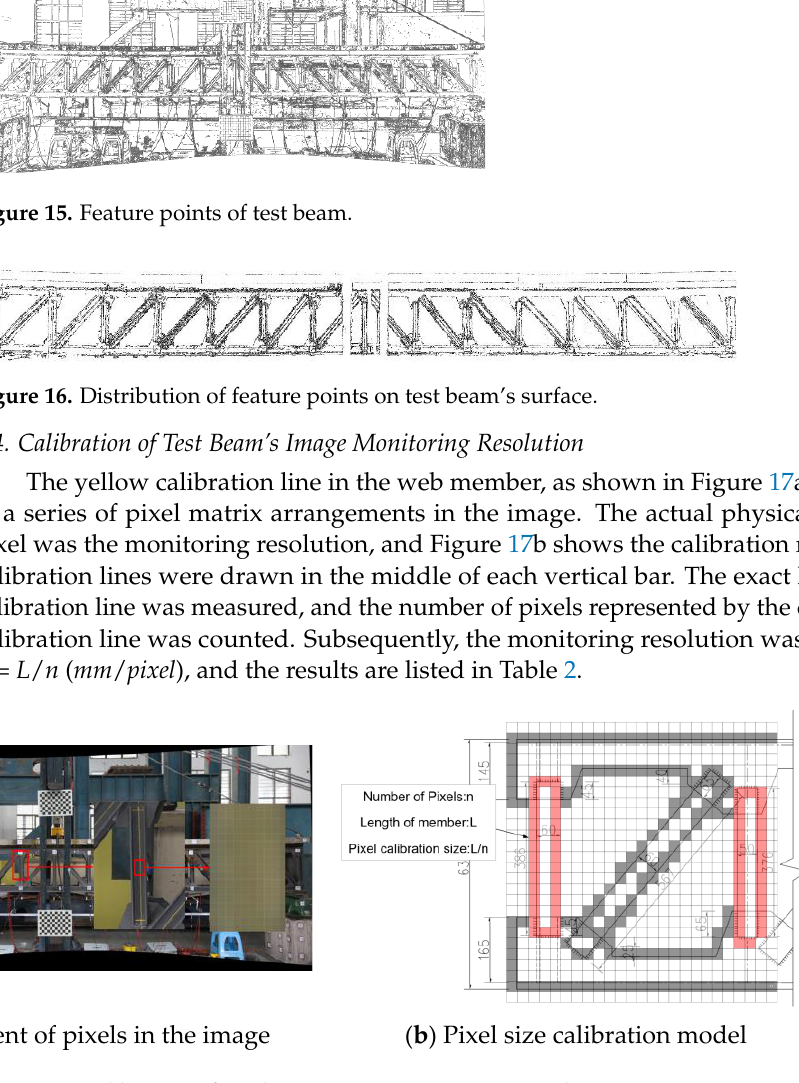
Figure 17. Calibration of test beam’s image monitoring resolution. Table 2. Resolution